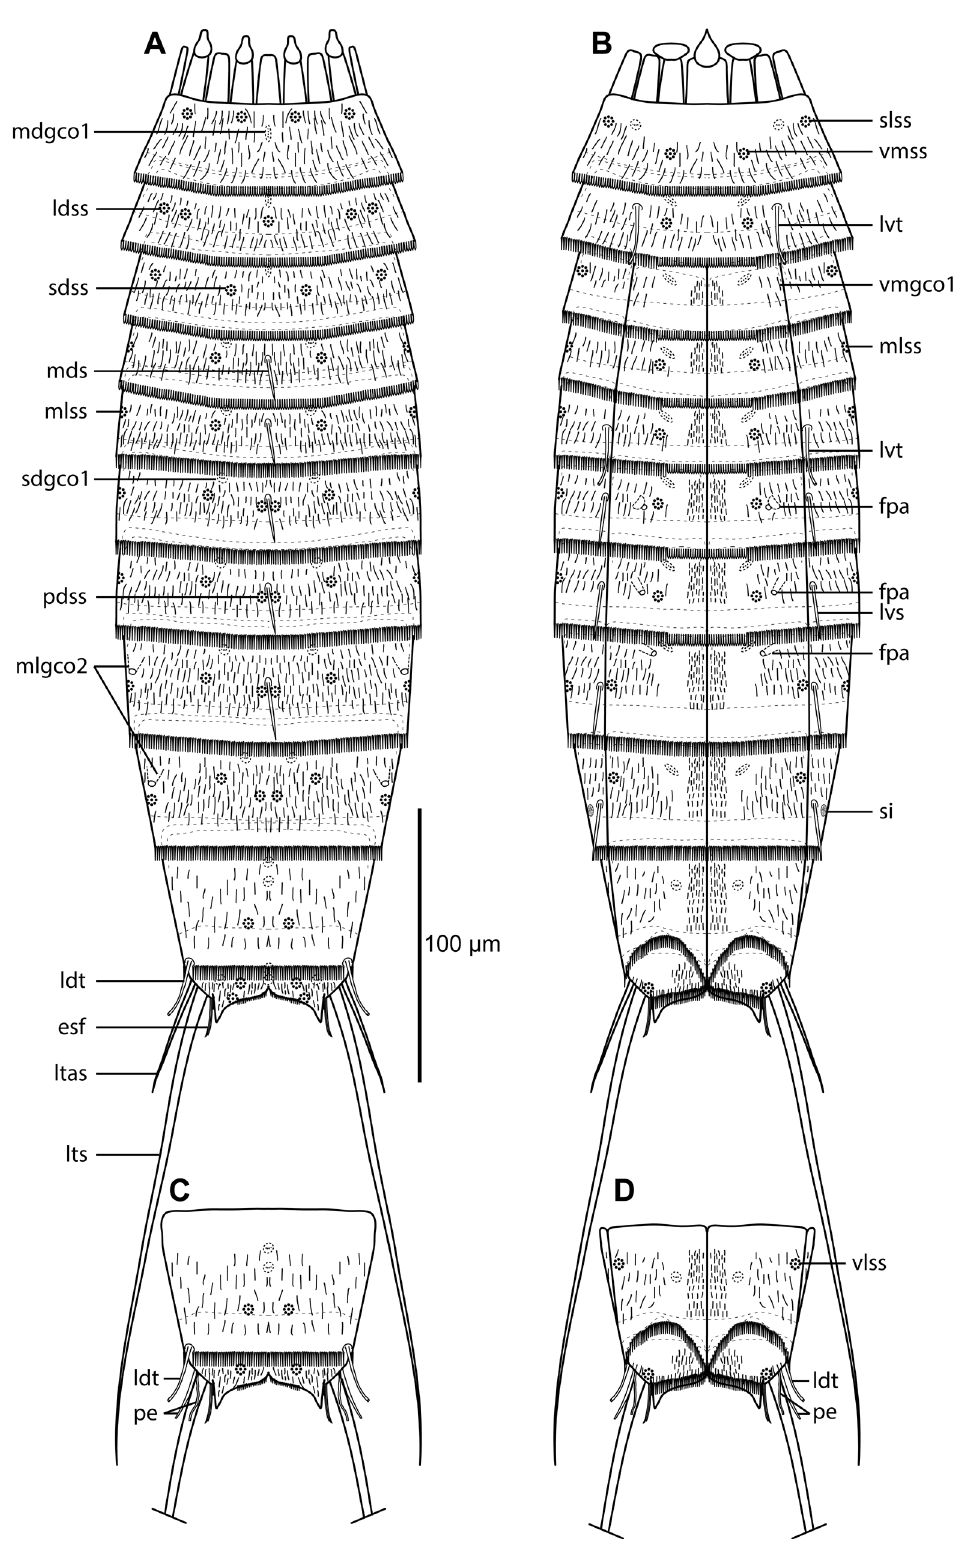
Fig. 12. Line art illustrations of Echinoderes sensibilis Adrianov et al ., 2002 . A . Female, dorsal view. B . Female, ventral view. C . Segments 10 to 11 in male, dorsal view. D . Segments 10 to 11 in male, ventral